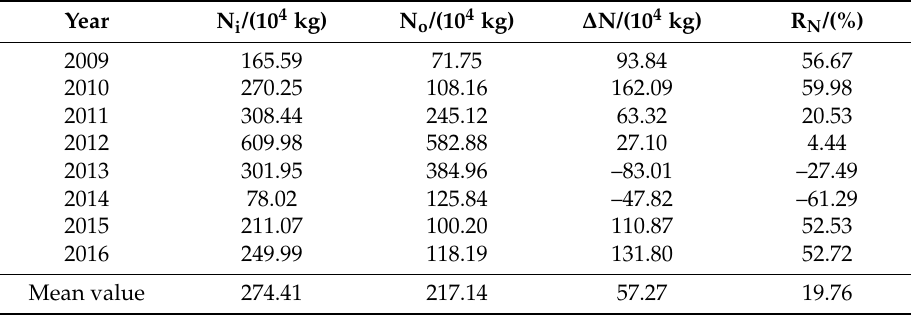
Table 2. Annual TN accumulation of the Biliuhe reservoir